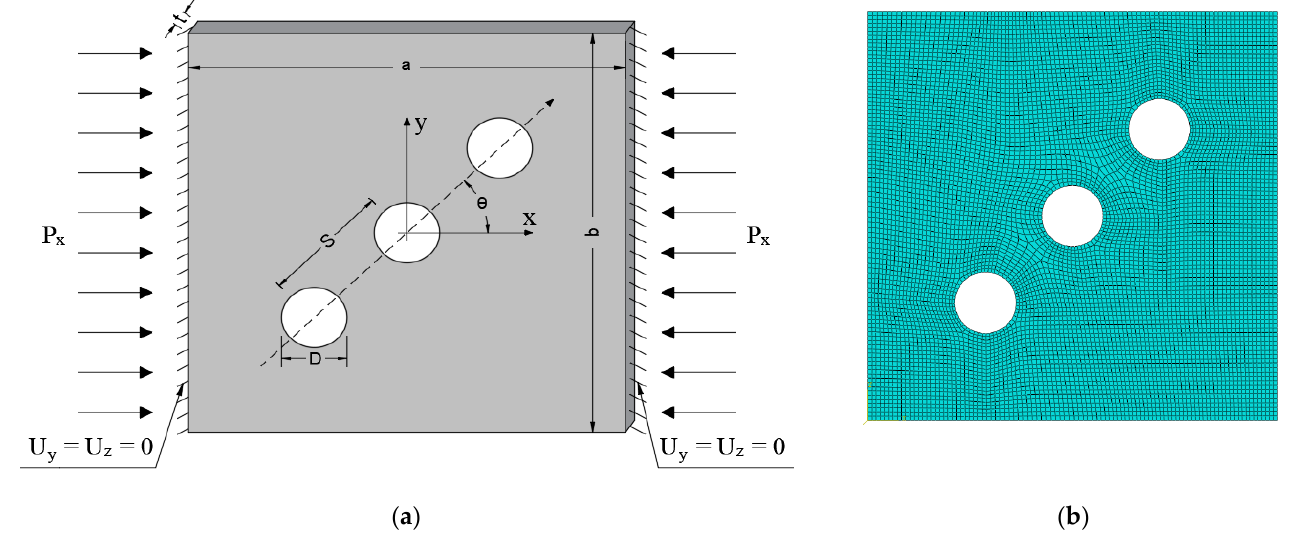
Figure 2. ( a ) The schematic of the FGM plate; ( b ) Meshing details.